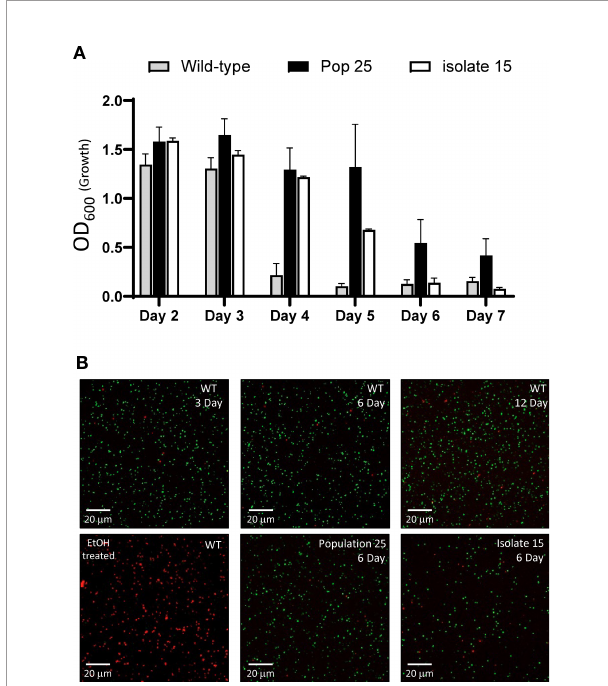
FIGURE 9 | Bio fi lm forming isolates delay the onset of a viable, but non- culturable state. (A) F. tularensis LVS (grey), a bio fi lm forming population (black) and a puri fi ed constitutive bio fi lm forming isolate (white) derived from wild-type LVS were streaked onto chocolate agar and incubated at 37°C. At the time indicated, CDM was inoculated and incubated shaking at 37°C for 24 h. The OD 600 was obtained as a measurement of bacterial growth. Samples were diluted as required to maintain the linear range of measurement. Graphed data show the average of at least 3 independent experiments with the standard error of the mean. (B) An aliquot of the bacteria present from the 24h broth culture was assayed for viability using Live/DEAD stain followed by fl uorescent microscopy. In these representative images, bacteria with an intact membrane (live) stain green while those with an impaired membrane (dead) are indicated by red staining. LVS exposed to 70% EtOH for 15 minutes was stained and imaged alongside samples to serve as a